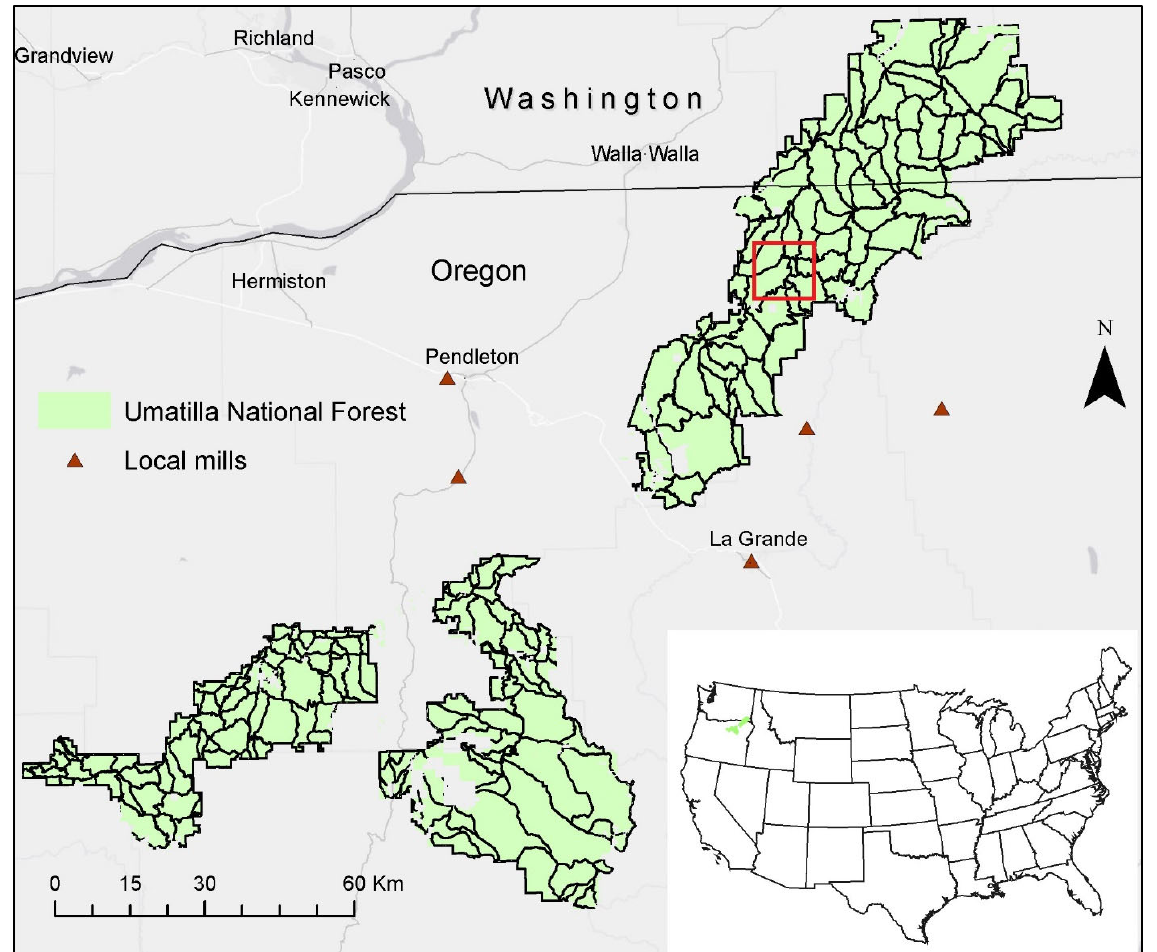
Figure 1. Map of the Umatilla National Forest illustrating the fuel break network (dark black lines) and local mills.